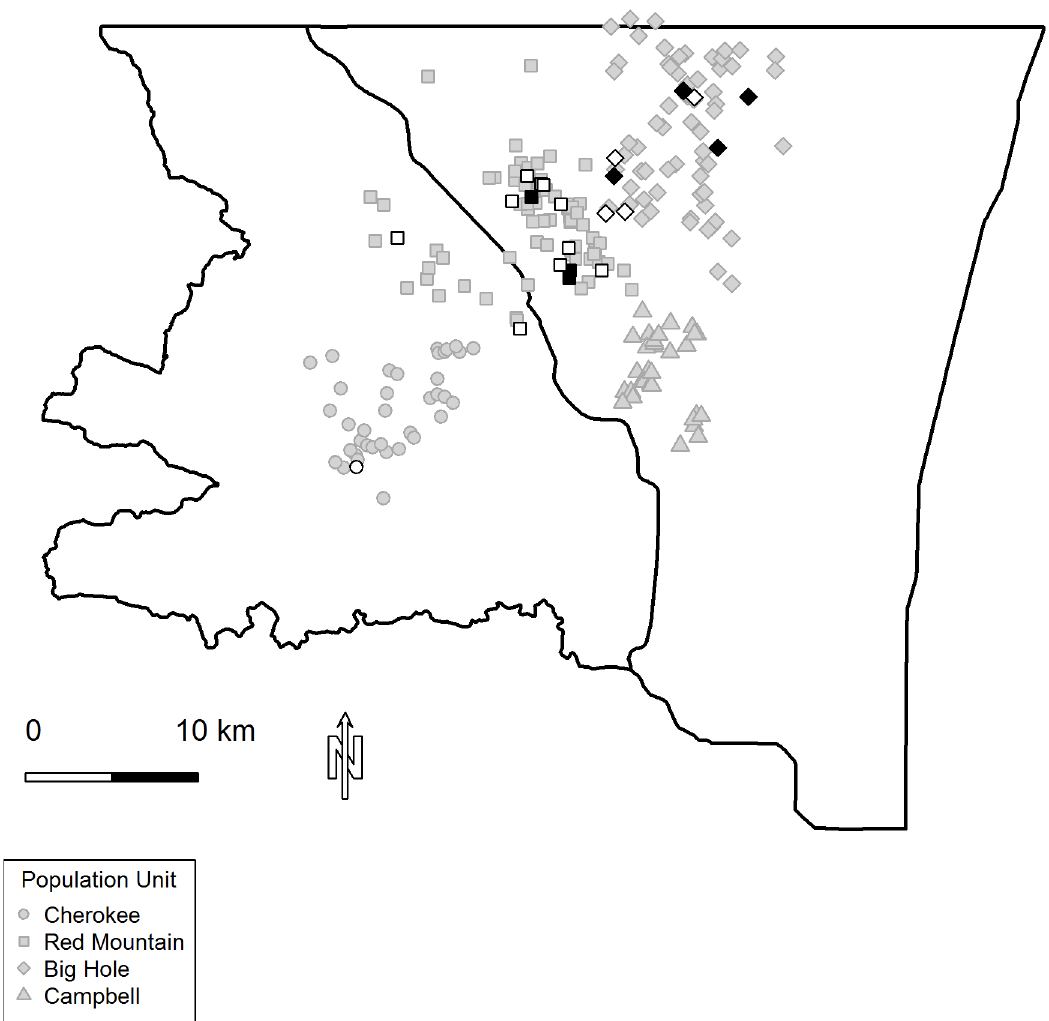
Fig 3. Spatial distribution of CWD infected deer. Median winter locations of female mule deer studied during 2010 – 2014. Deer that entered (black) or converted (white) to CWD positive were mostly located in a 50 km 2 region in the center of the study